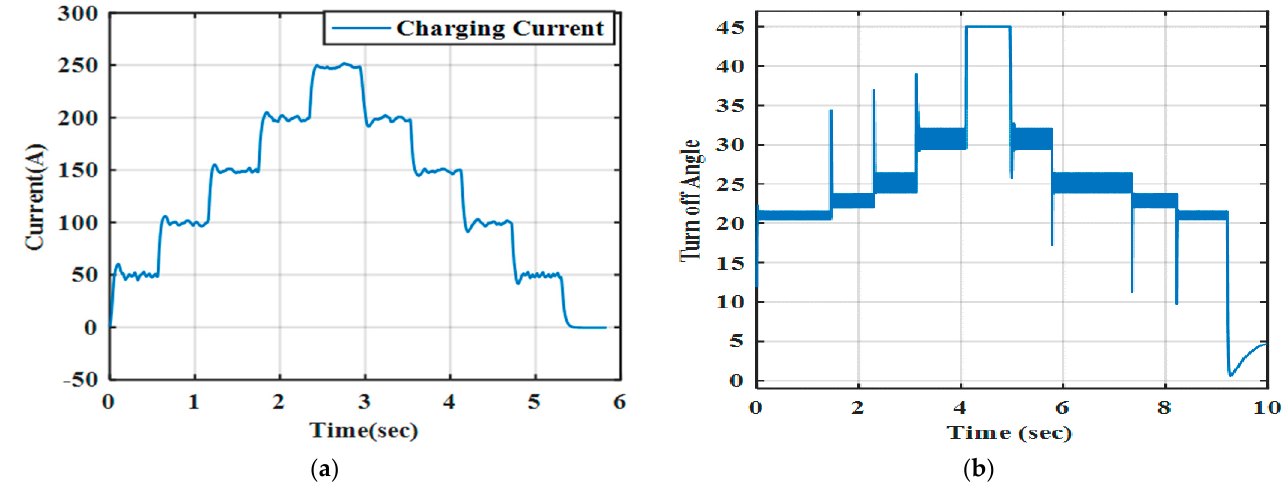
Figure 21. Opal-RT real-time simulator turn-off angle control on constant current response (V battery = 250 V, θ on = 0°), ( a ) the constant current at different reference values, ( b ) the corresponding turn-off angle.